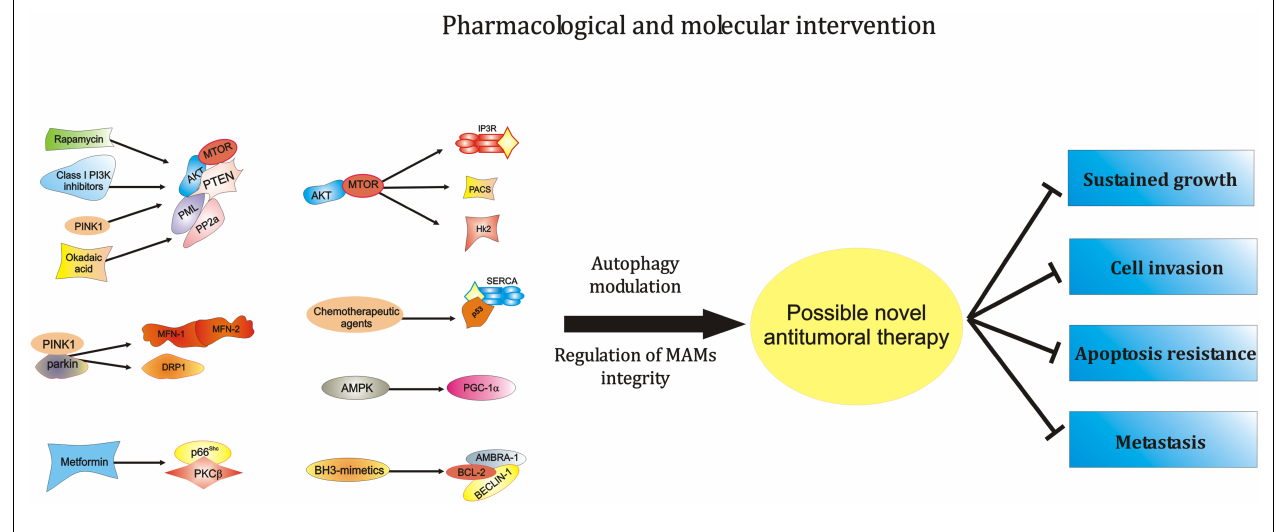
FIGURE 2 | Modulation of the activity of ER-MAMs protein may represent a novel therapeutical strategy against carcinogenesis . MTOR, the main regulator of autophagic process, was found to modulate MAMs structure and activities. In addition, other PI3K family members, like AKT and PTEN, are located at ER-MAMs sites and represent critical regulator of autophagy and MTOR activity. Of relevance, these PI3K family members may be modulated by rapamycin and class I PI3K inhibitors. Furthermore, since the interaction of AKT-PTEN axis with the tumor suppressor PML and the protein PP2A at MAMs level is well described, it is possible to hypothesize a pharmacological intervention at this level to modulate the autophagic process during tumorigenesis. Also, the most studied tumor suppressor, p53, recently found to be located at ER-MAMs sites, was found to regulate autophagy. It is so clear that chemotherapic agents activating p53 may exert their antitumor activities at ER-mitochondria contact sites in an autophagy-dependent manner. Another critical regulator of autophagy, AMPK, was recently found to destabilize the correct juxtaposition between ER and mitochondria. Interestingly, the pharmacological AMPK-activator Metformin is found to regulate the activity of PKC β . It is easy to think that metformin may interfere with the recent